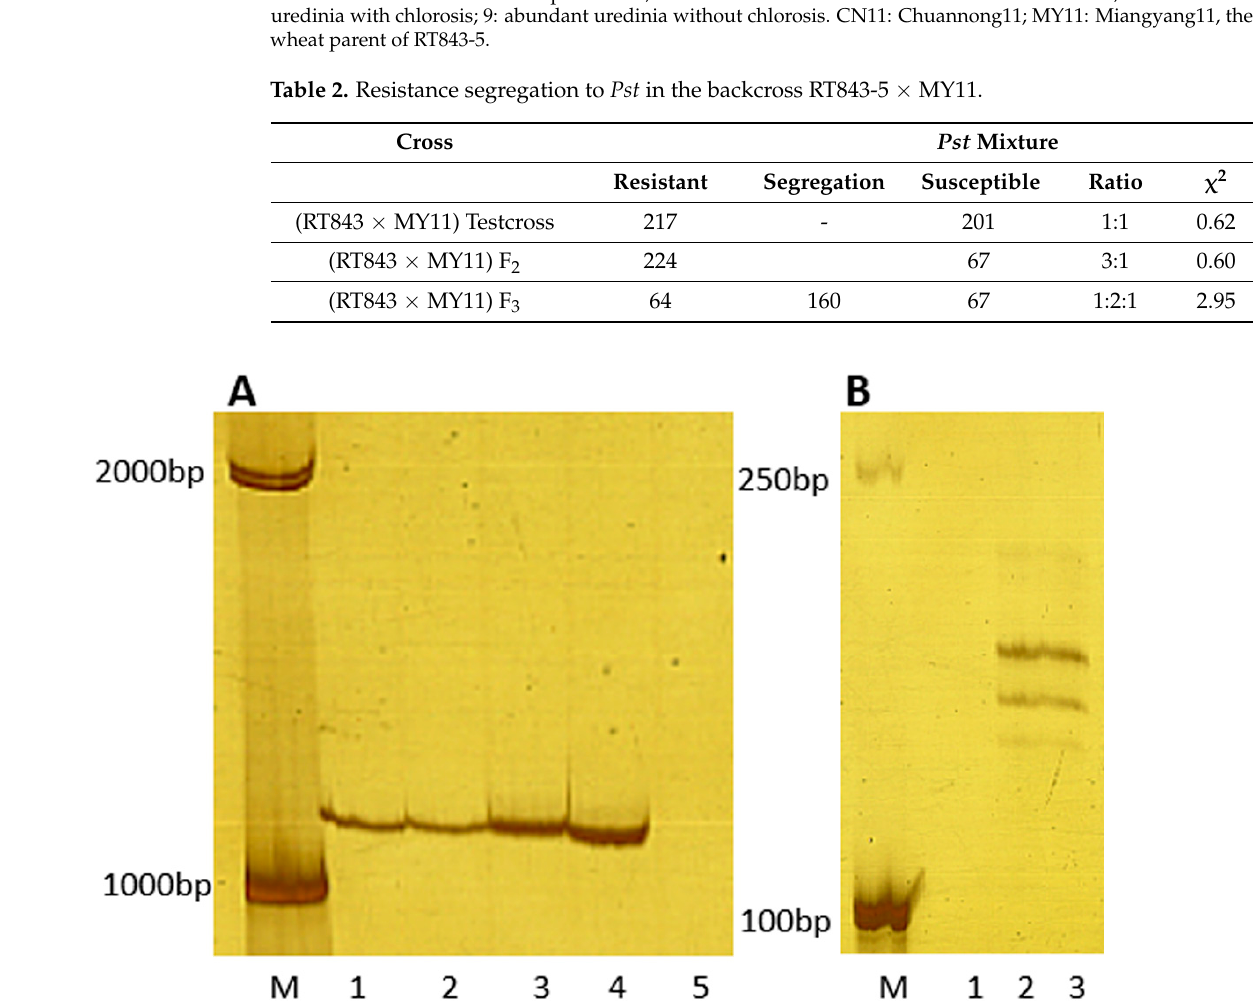
Figure 3. PCR results from primers Iag95 and Xgwm582. ( A ): PCR results of Iag95. Lane 1: